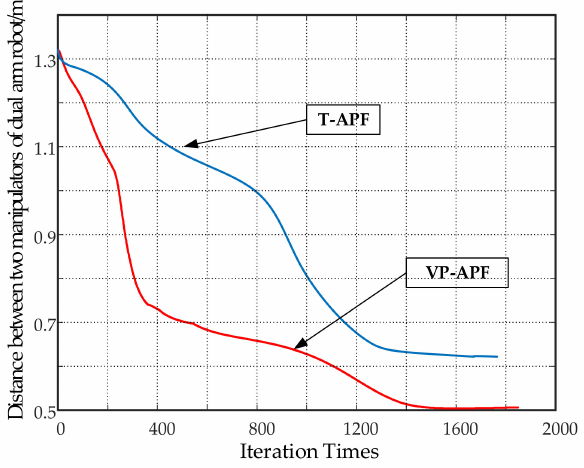
Figure 11. Variation of distance between two manipulators with VP-APF and